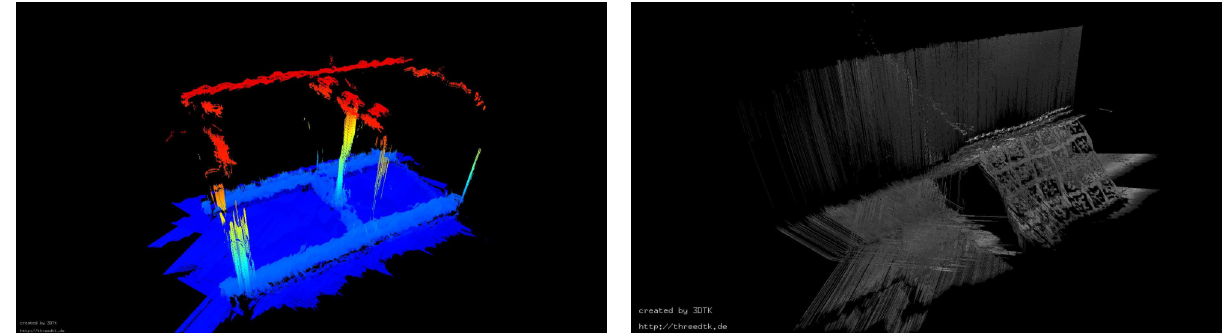
Figure 8. Example of captured point cloud from the floating platform using the GNSS-INS trajectory. Left: Point cloud of the pipe structure colored by height, Right: Point cloud of a calibration target colored by